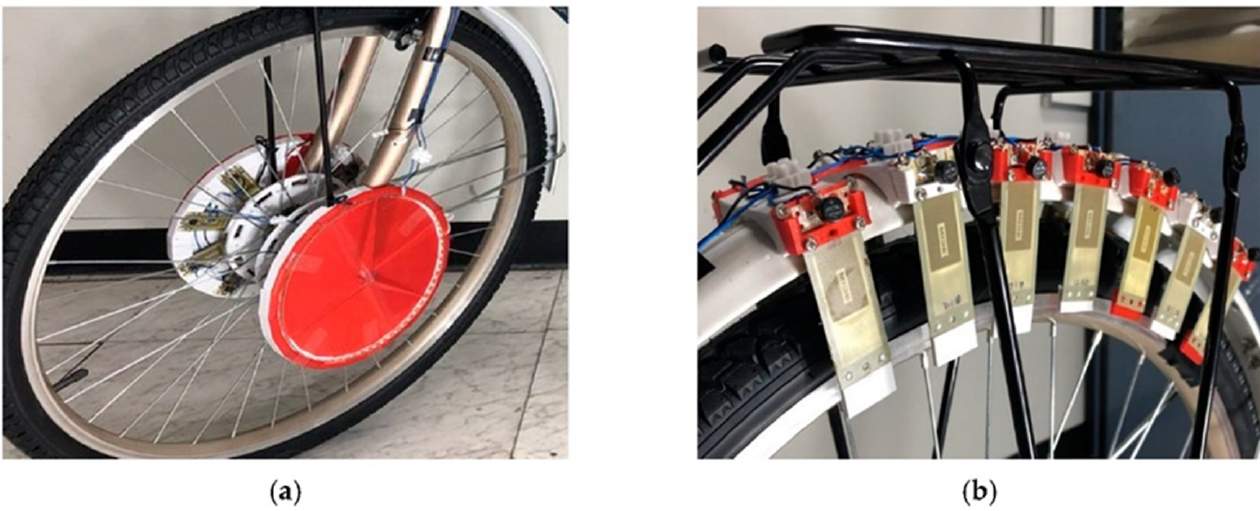
Figure 5. The installation of piezoelectric energy harvesters on a bicycle. ( a ) Piezoelectric harvesters installation distance at front wheel; ( b ) Piezoelectric harvesters installation distance at rear wheel fenders., adopted from [1].